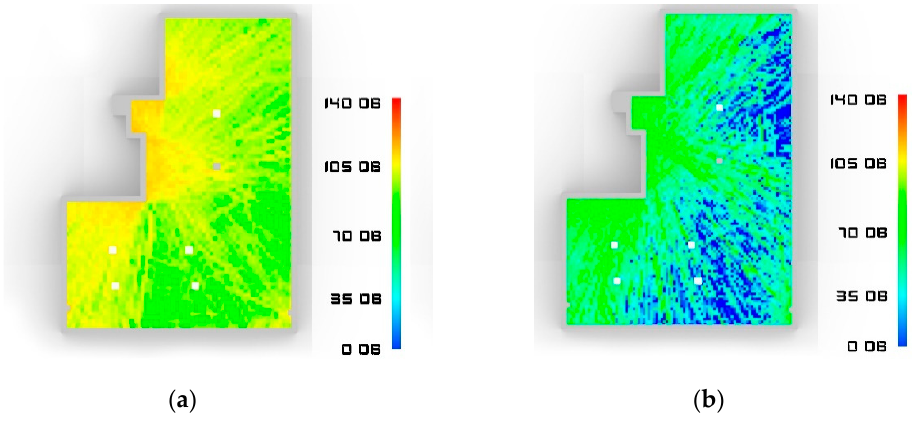
Figure 10. Visualizations of sound pressure level using the 3D Smart Particle System: ( a ) visualization of the hall without acoustic treatment and ( b ) visualization of the hall when adding acoustic treatment (absorptive